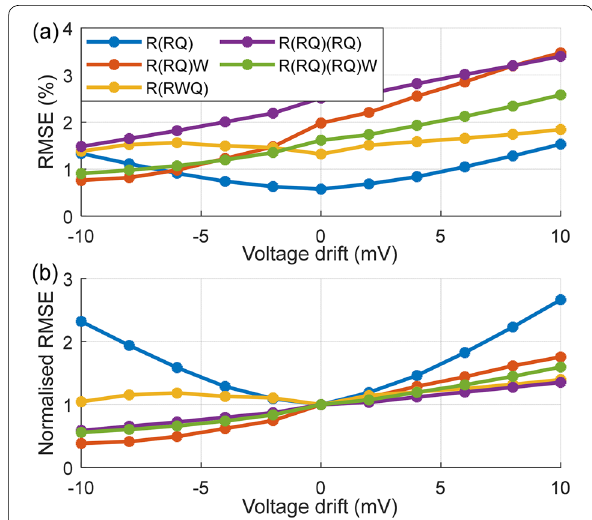
Figure 13 Influence of voltage drift on SOC estimation error: a RMSEs versus voltage drift, b Normalised RMSEs based on RMSEs under no voltage drift